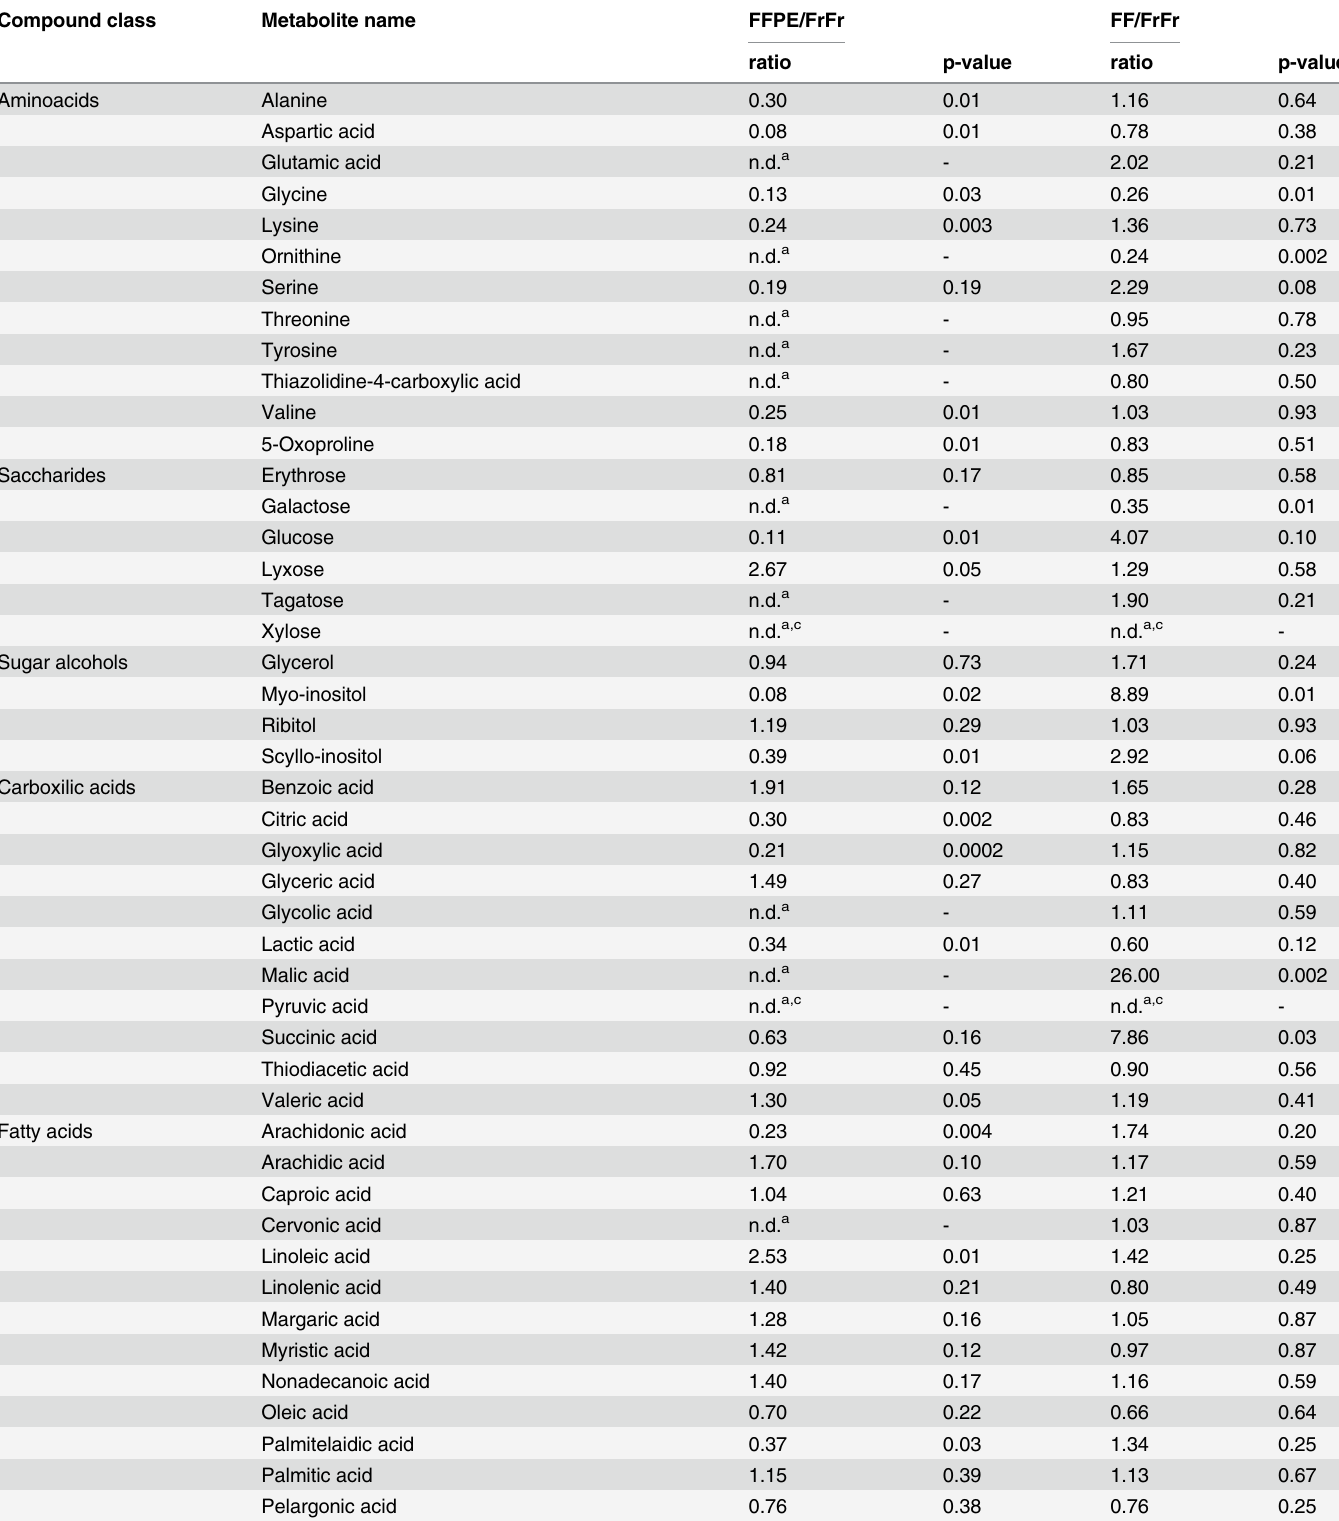
Table 1. Metabolites detected by GC/MS in different preparations of mouse kidney – comparison between different types of tissue preparations. Compound